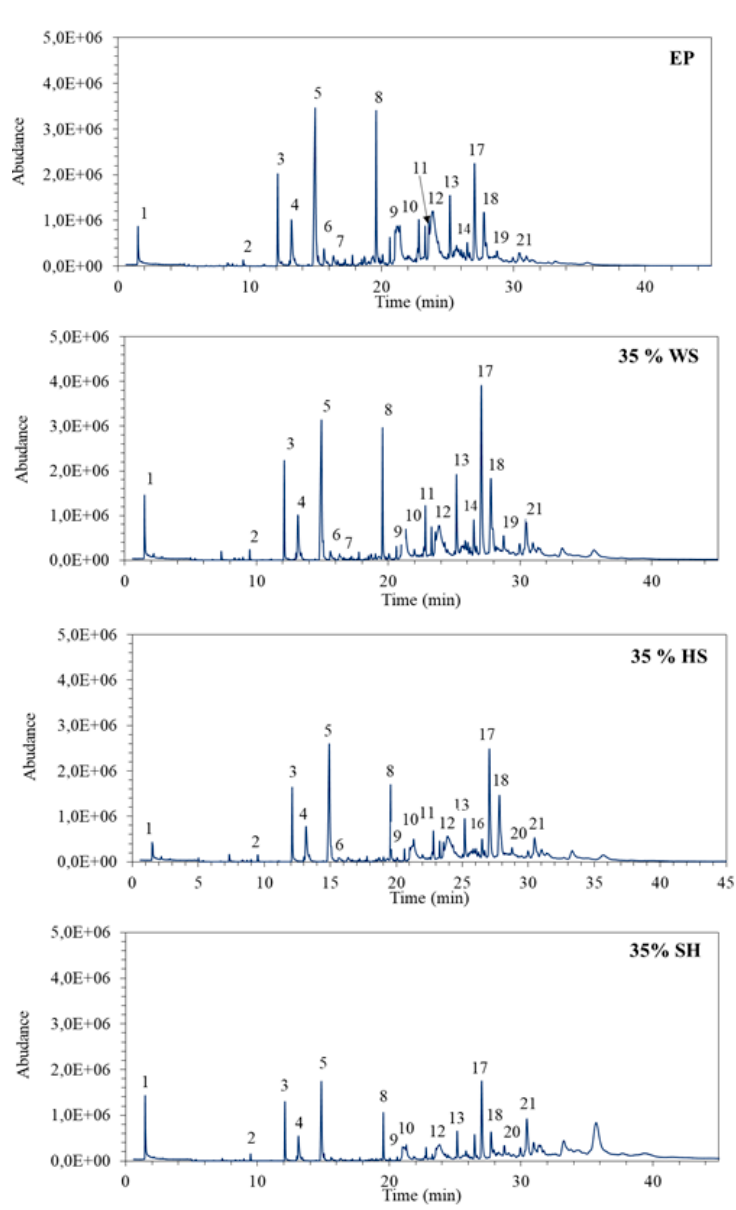
Figure 11. Chromatograms from analysis of thermal degradation products of selected modified epoxy composites at 650 °C.